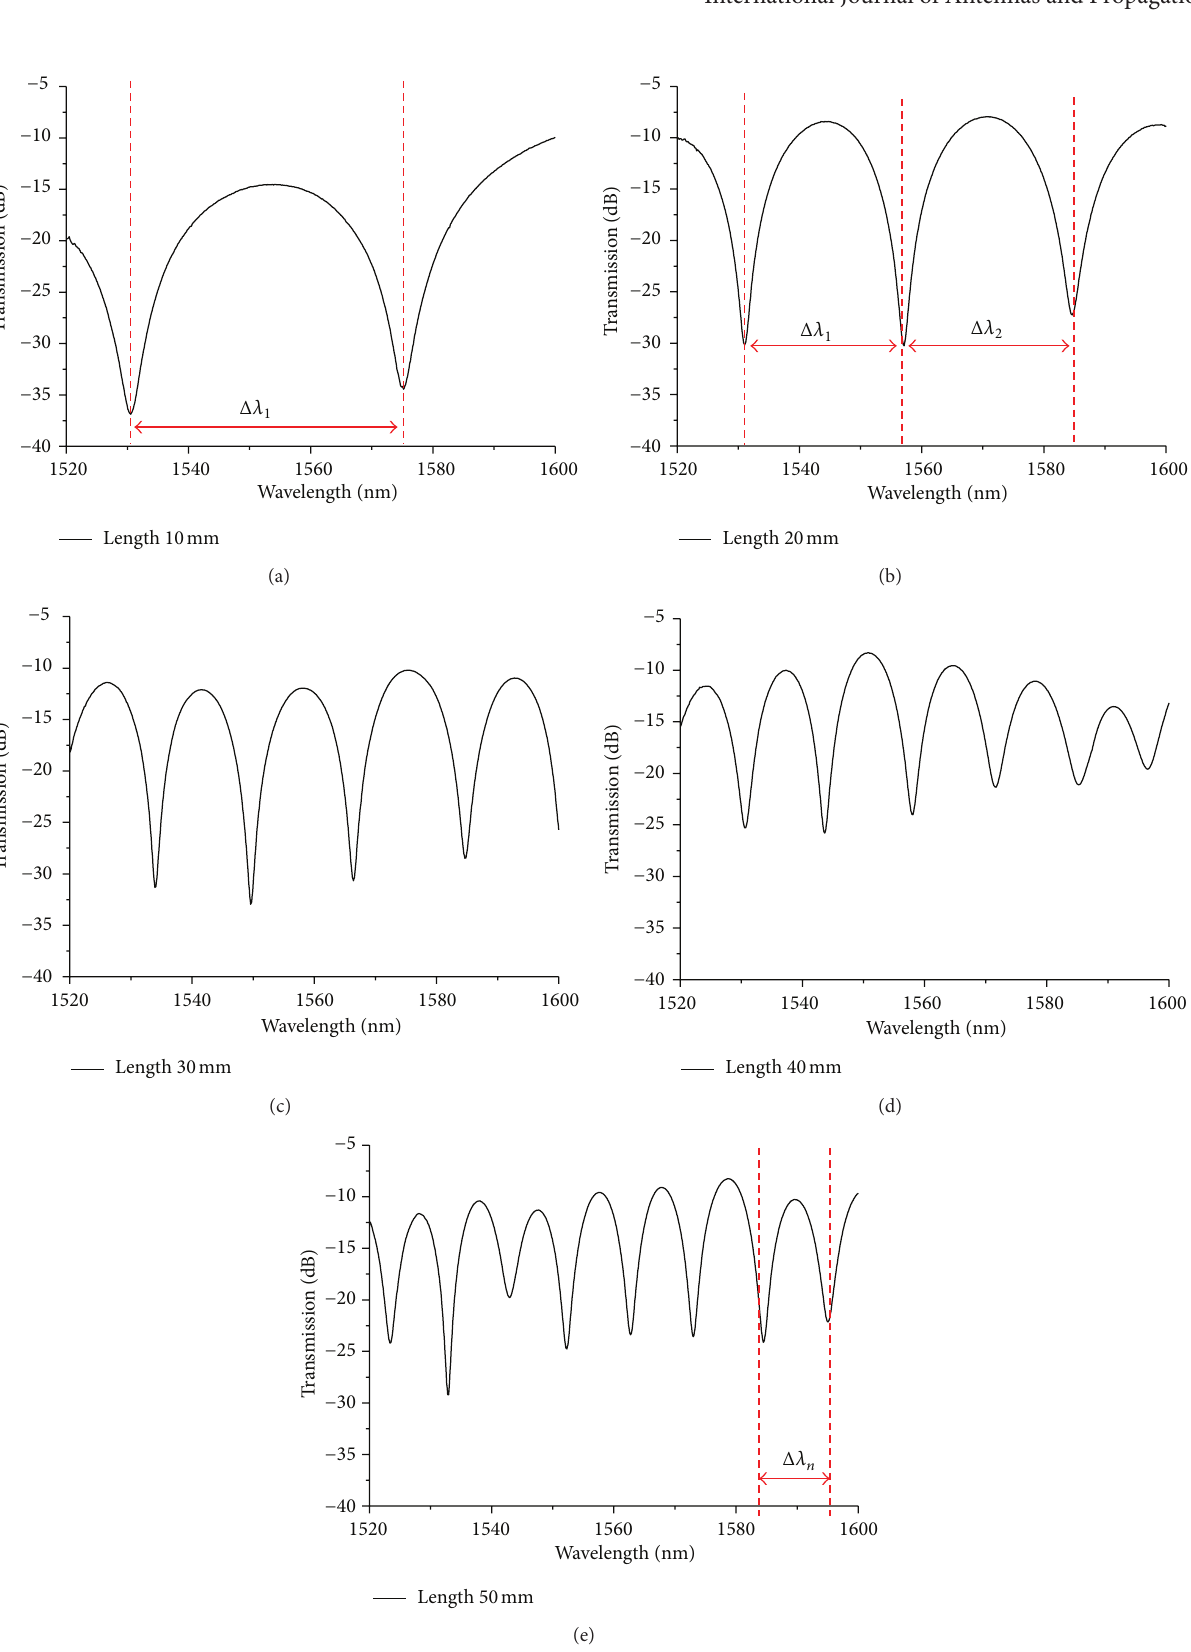
Figure 9: The relationship between various lengths and interference